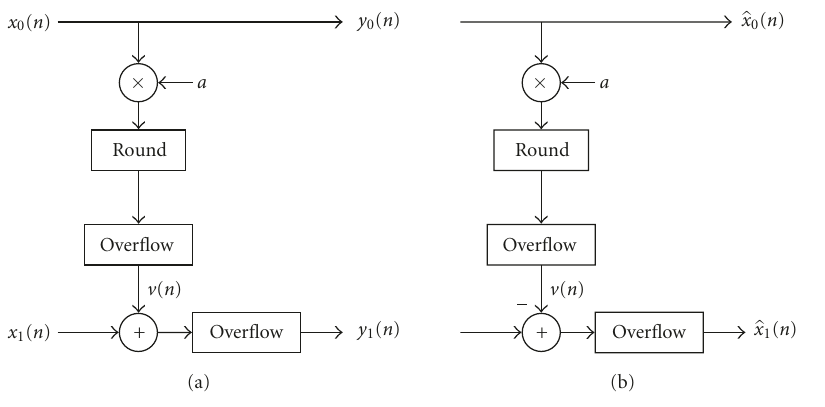
Figure 1: Fixed-point implementation of a lifting step and its